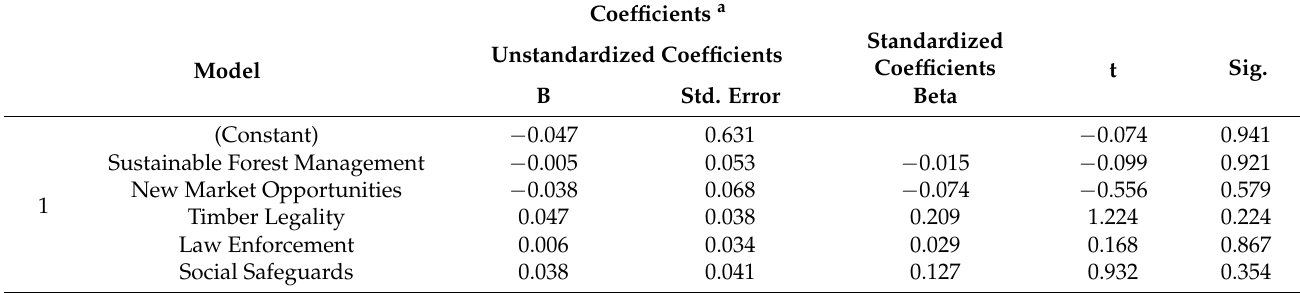
Table A3. Heteroskedasticity Test